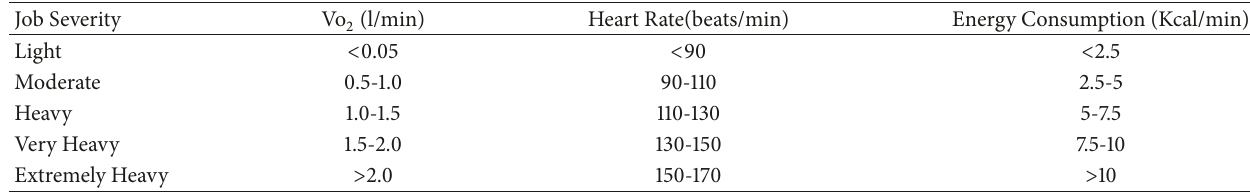
Figure 2: Variance test for heart rate study. Table 1: Job severity classification according to Astrand and Rhodahl [20].